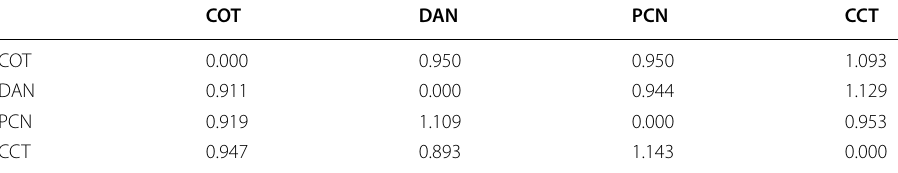
Table 6 Score function for the wj values of quantum spherical fuzzy sets COT DAN PCN CCT COT 0.000 0.950